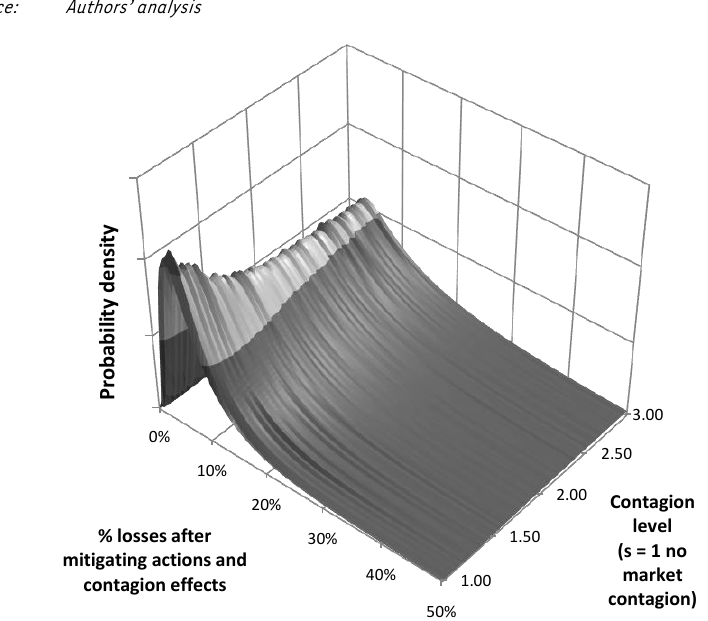
FIGURE 18: South African bank liquidity buffer losses affected by the